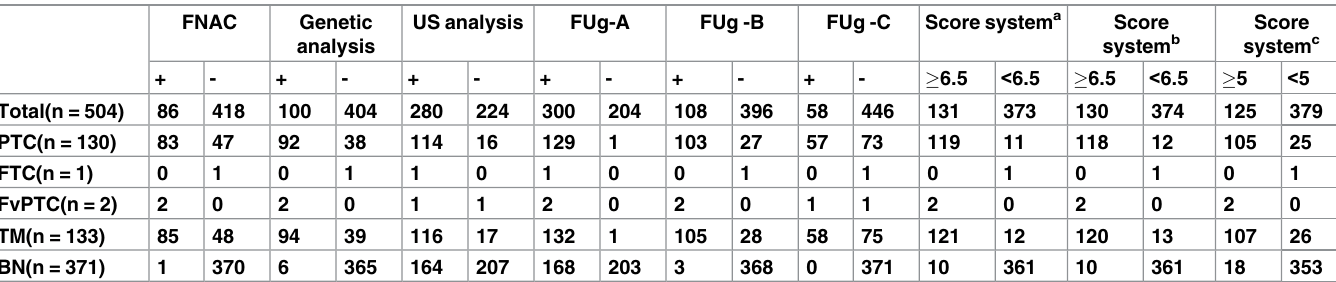
Table 4. The distribution of postoperative pathological results.